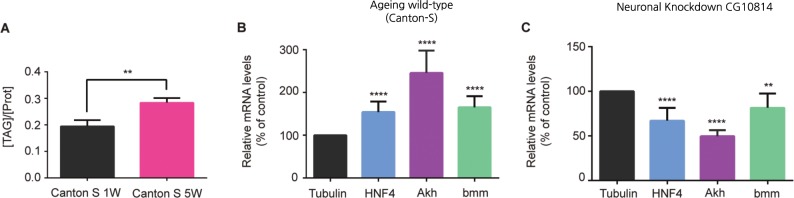
HNF4 and lipid mobilization genes dAkh and bmm are upregulated with age in wild-type flies (Canton S) together with TAG content in fly heads.(A), Biochemical comparison of Triacylgyceride content in young and old fly heads. Amount of TAG was normalized to the amount of protein. (**p<0.01; SEM is indicated with n = 4; Paired Student’s t-test). (B), Relative changes in mRNA transcript levels of HNF4, dAkh and bmm in ageing wild-type (Canton S) fly brains (5 week vs 1 week). αTub84B was used as normalization reference (****p<0.0001; SEM is indicated with n≥3; Unpaired Student’s t-test). (C), Relative quantification of dHNF4, dAkh and bmm mRNA levels from brains of neuronal specific knockdown of CG10814 (nSybGAL4>UAS-CG10814RNAi) flies compared to age-matched controls, at 5 weeks of age. αTub84B was used as normalization reference(**p<0.01, ****p<0.0001; SEM is indicated with n≥6; Unpaired Student’s t-test). CG10814 loss of expression (knockdown) in fly brain down regulates expression of genes involved in activation of β-oxidation and lipid metabolism at 5W.